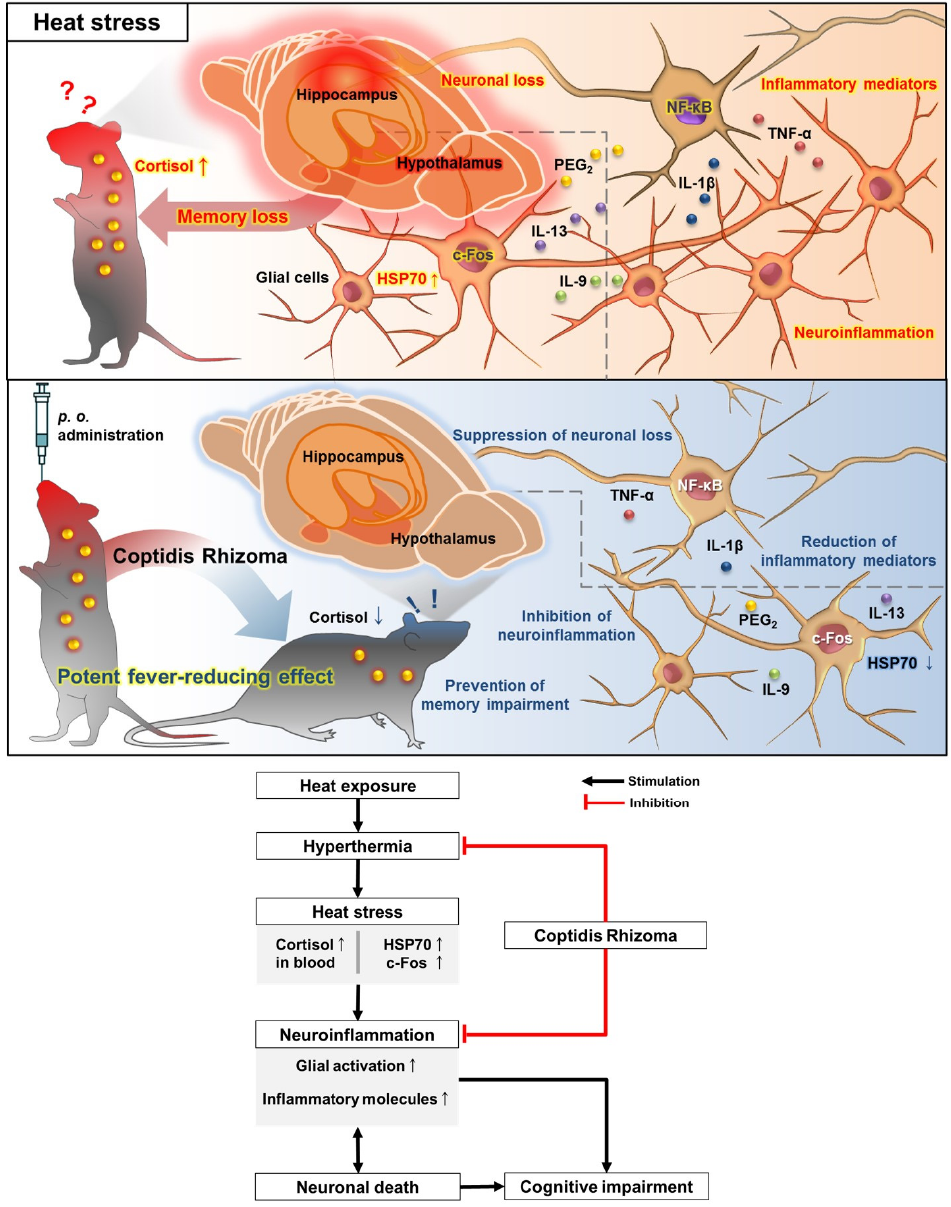
Figure 9. Schematic diagram of the protective effects and proposed therapeutic mechanisms of Coptidis Rhizoma against heat stress ‐ induced damages in the brain of mice.